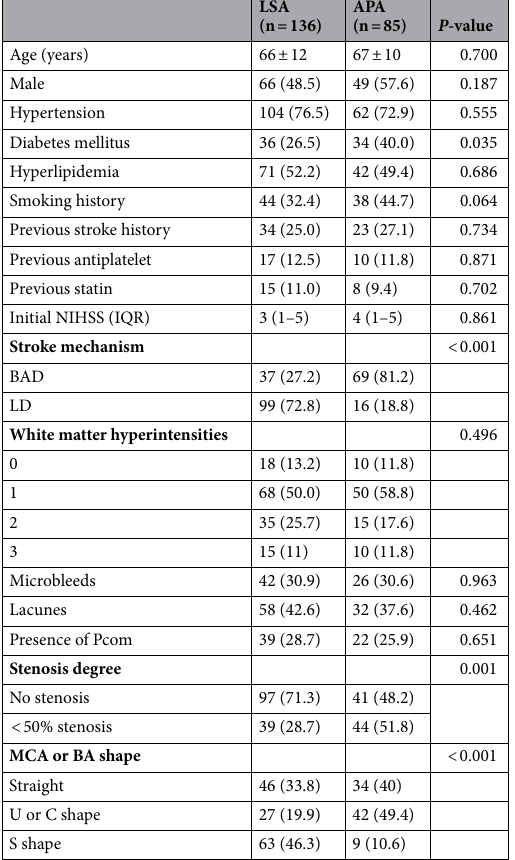
artery, BA: basilar artery, BAD: branch atheromatous disease, LD: lipohyalinotic degeneration; NIHSS: National Institutes of Health Stroke